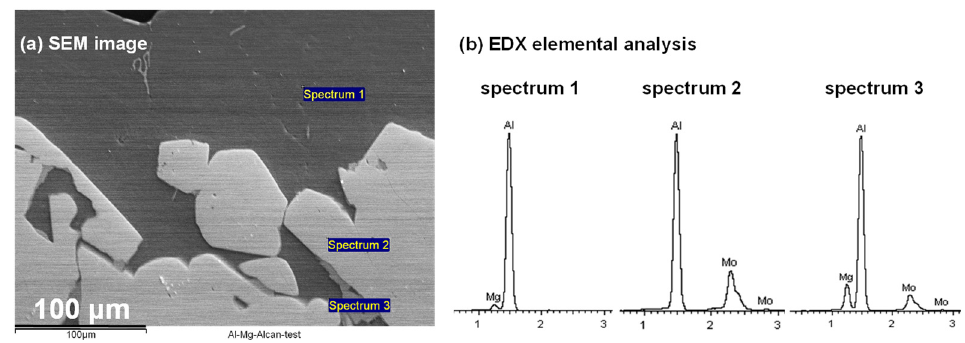
Figure 15. ( a ) The BEI by SEM complemented by ( b ) EDX spectra of the Al-Mg alloy solidified on the Mo block, comprising the deeper bulk Al-Mg-rich areas (spectrum 1); the outer Al-Mo-rich coating (spectrum 2); and the scanty intermediate region with Al-Mg-Mo coating (spectrum 3). It has been observed that interactions of metallic materials with molten Al possess some common features, as they all form intermediate layers of intermetallic compounds between the metal substrates and molten Al, and these layers usually consist of either one phase or several phases, depending on the composition of the substrate and the reaction